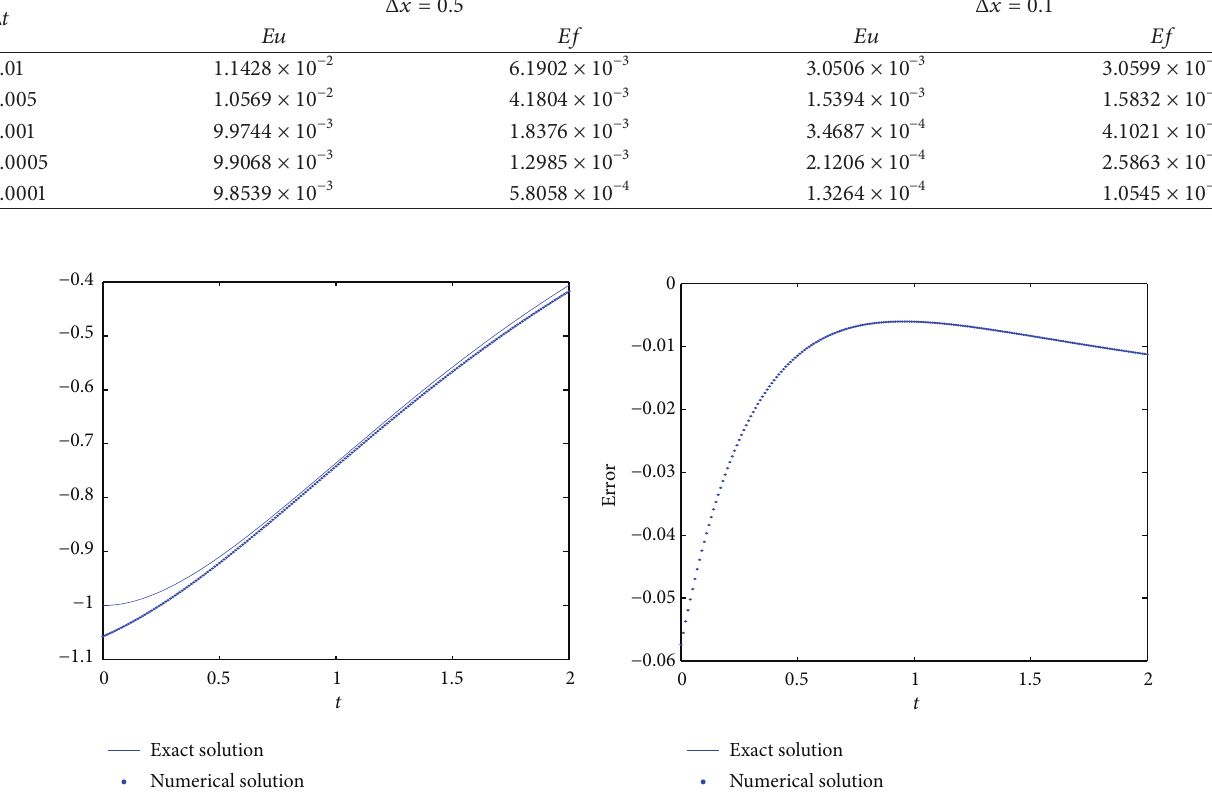
Figure 1: The exact solution 𝑓(𝑡) and the numerical solution of